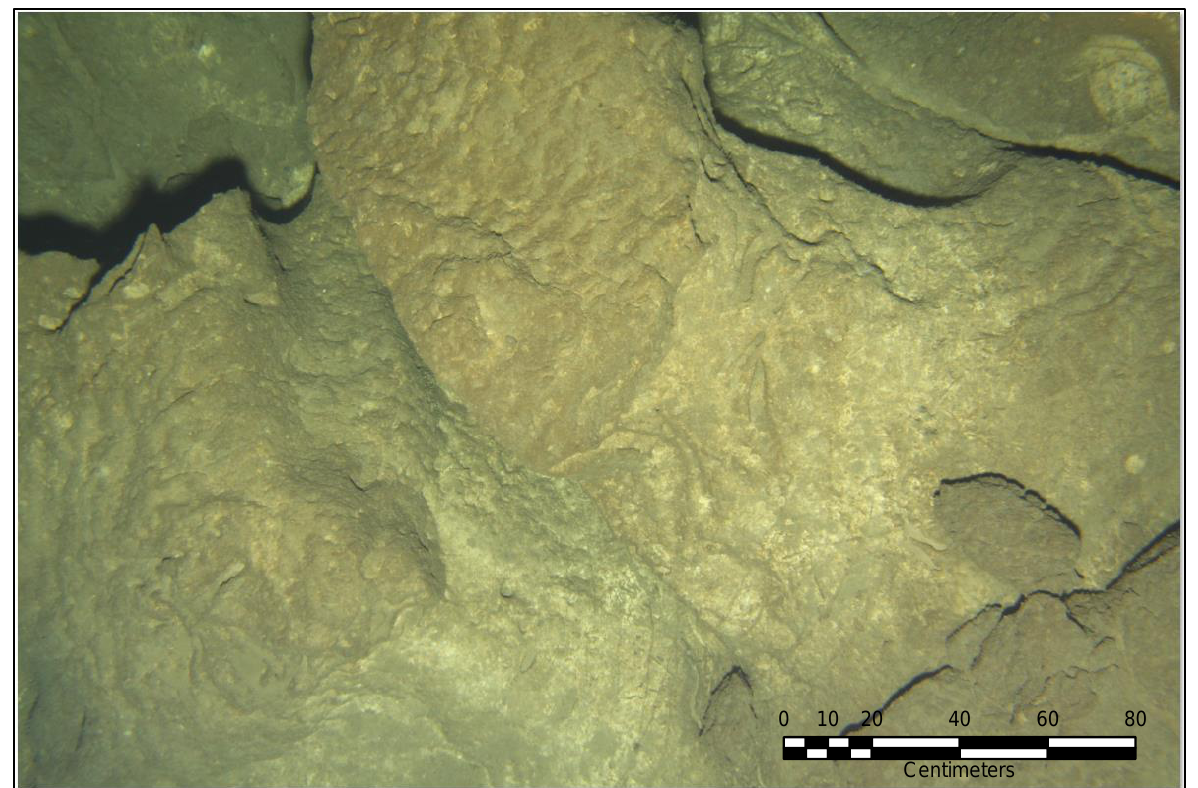
Figure 12. Volcanic knoll crest example photo. Source: TOML image 2015_08_17_094309.